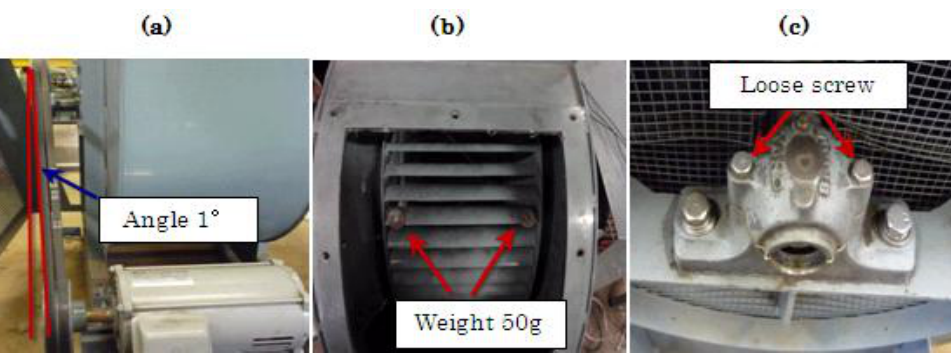
Figure 4. Structural faults (a) Misalignment state, (b) Unbalance state, (c) Looseness